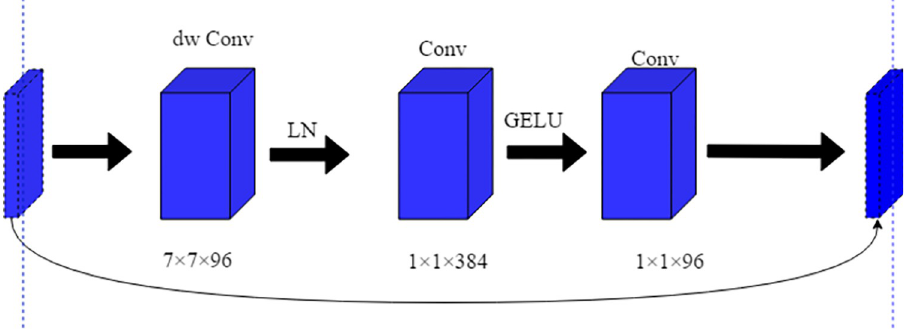
Fig 5. CNeB-block